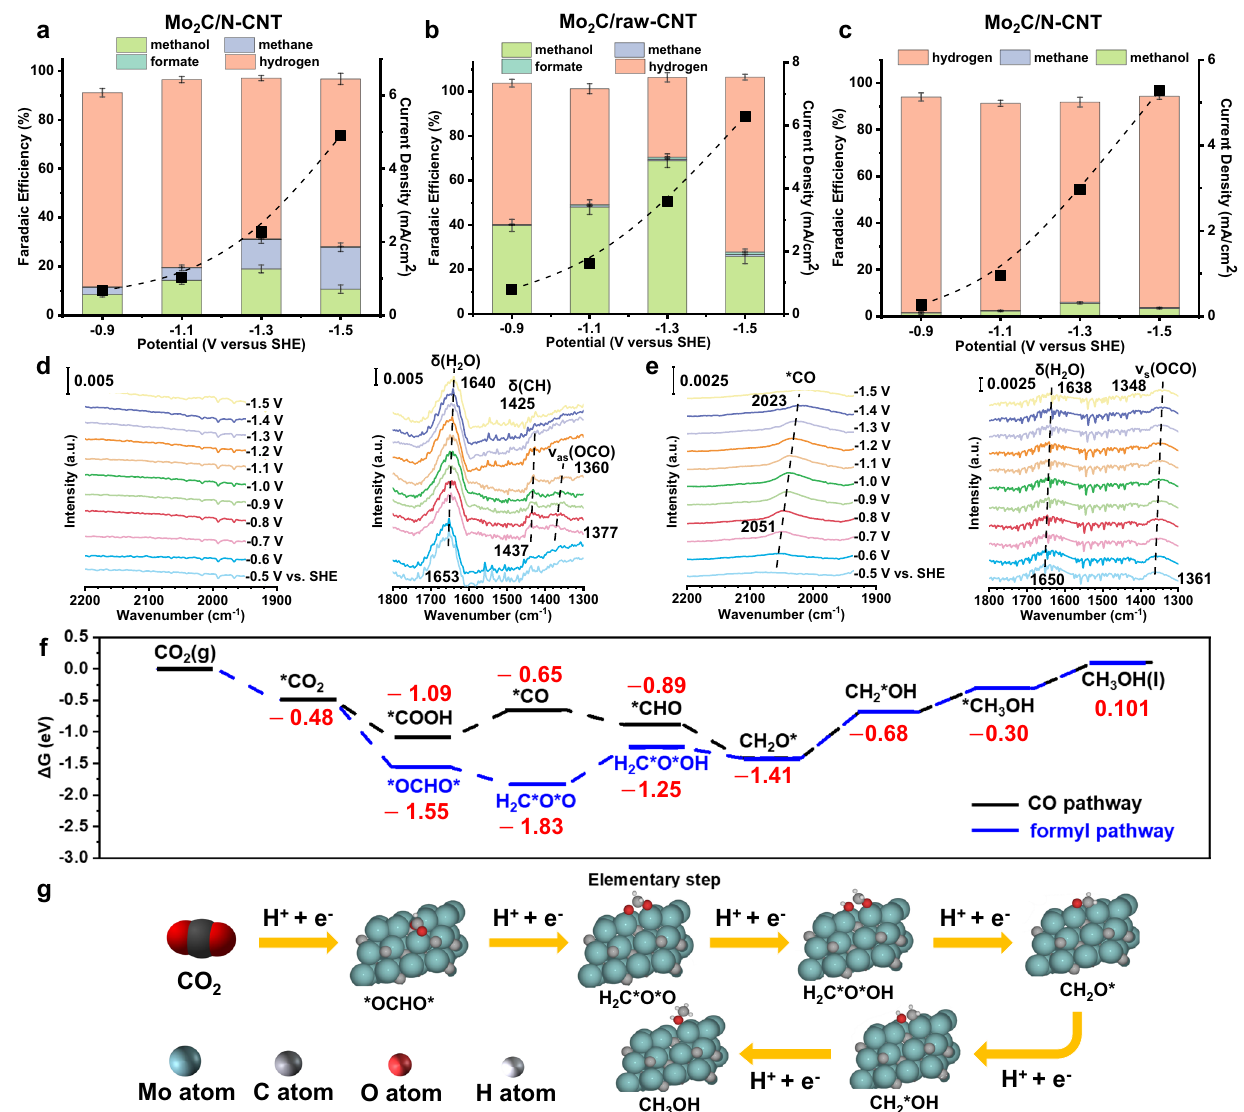
Fig. 4 | Mechanism exploration of the reaction of CO 2 reduction to CH 3 OH. a Productdistributions of Mo 2 C/N-CNT after 1h CORR under 40atmCOat various potentials(potassiumphosphatebuffer,pH~5.4). b ProductdistributionsofMo 2 C/ raw-CNT after 1h CH 2 O reduction with 0.1M potassium phosphate buffer (con- taining 100mM CH 3 OH-free CH 2 O) as electrolyte under 40atm Ar at various potentials. c Product distributions of Mo 2 C/N-CNT after 1h HCOOH reduction under40atmAratvariouspotentials.In-situATR-SEIRASspectraof d Mo 2 C/N-CNT